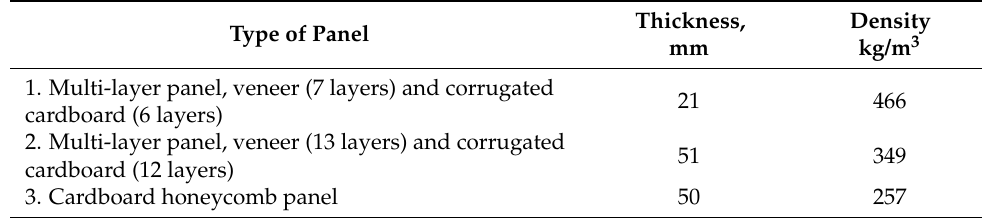
± 2 °C and 65% relative humidity.